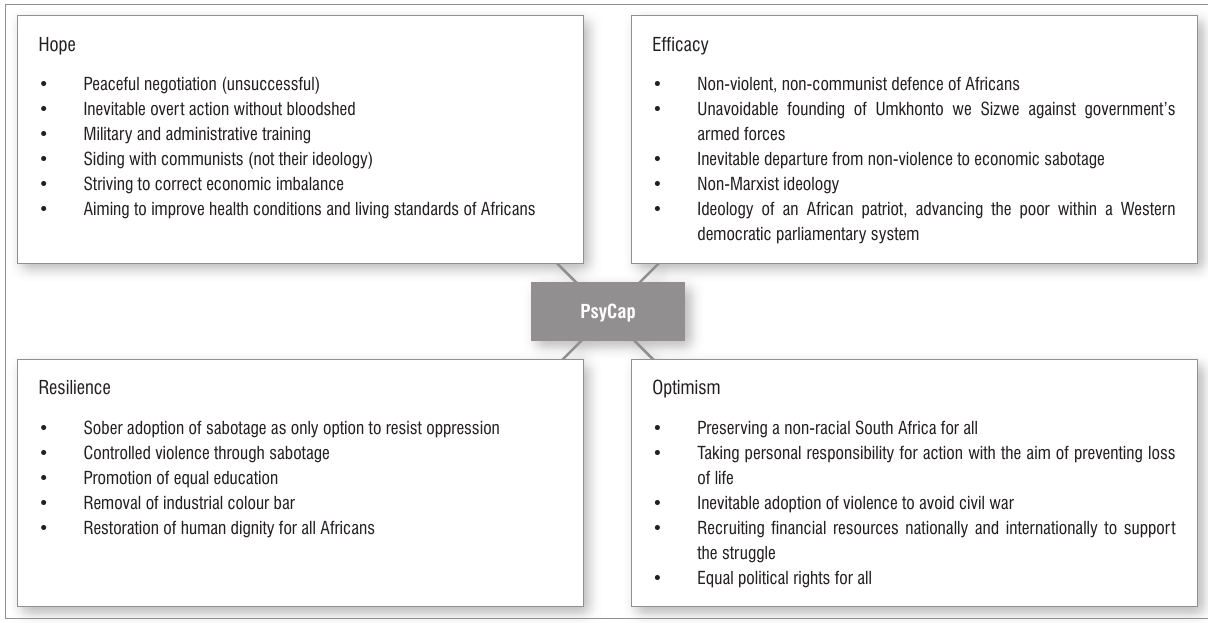
Figure 5: Psychological capital (PsyCap) HERO (hope, efficacy, resilience, optimism) themes in Nelson Mandela’s Rivonia Trial defence